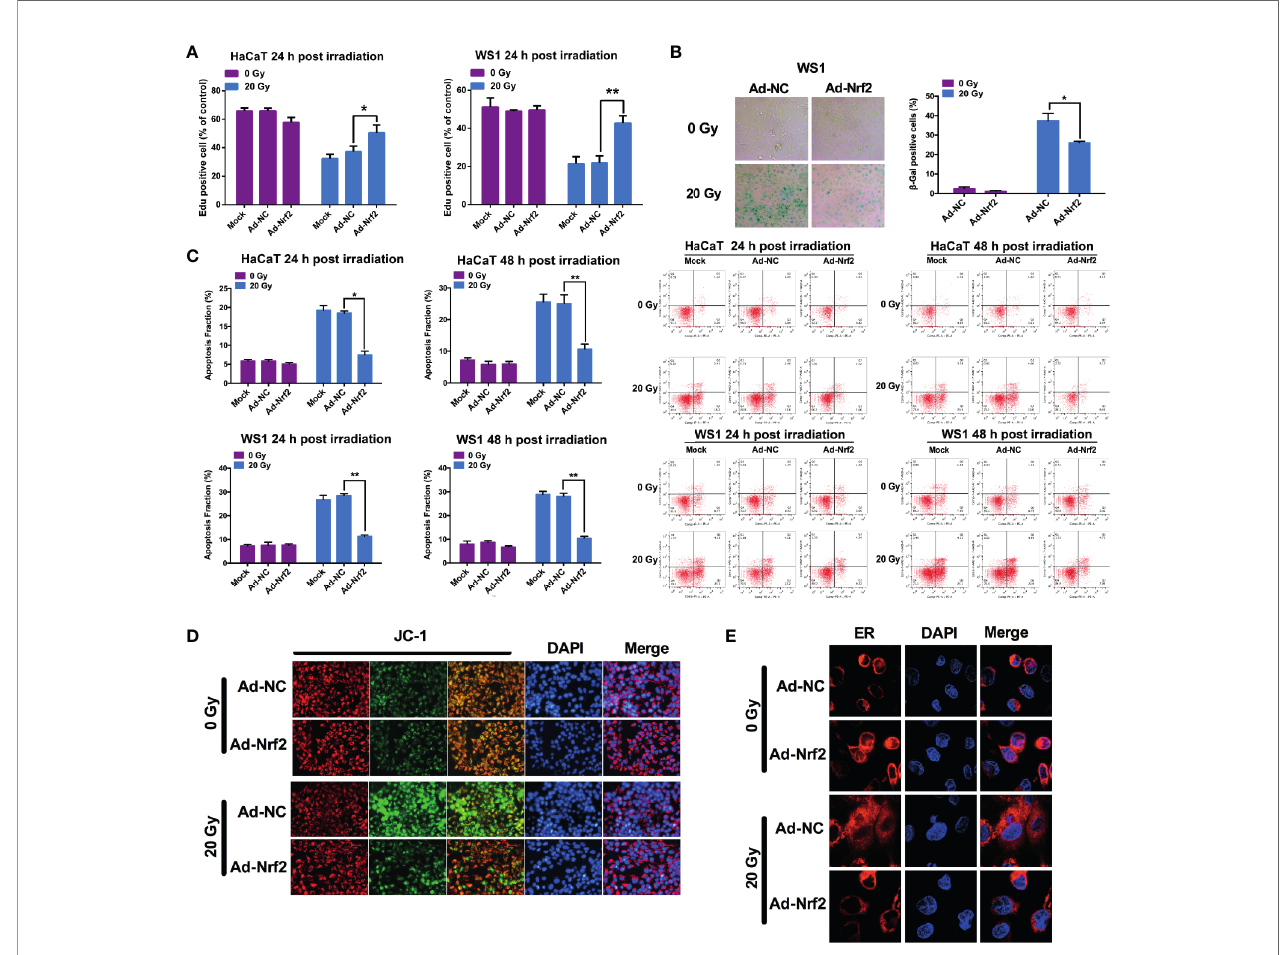
FIGURE 3 | Nrf2 restores cell viability and reduces cell death and senescence after irradiation. (A) The proliferation of HaCaT and WS1 cells was measured in an EdU incorporation assay at 24 hours after irradiation. (B) The cell death rate of HaCaT and WS1 cells was detected using Annexin-V/7-AAD staining. (C) The senescence of WS1 cells was evaluated using b -galactosidase staining. (D) The mitochondrial membrane potential in HaCaT cells was evaluated using a JC-1 staining assay. (E) The ER structure was visualized using ER-Tracker Red. * means p < 0.05, ** means p <